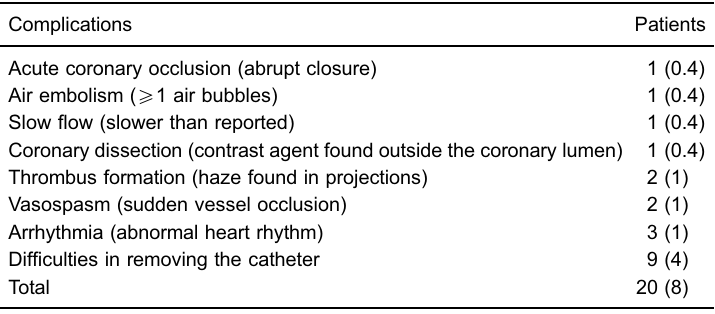
Table 4. Complications related to percutaneous coronary intervention